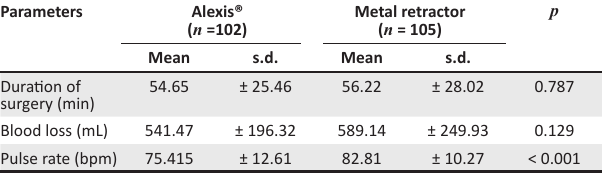
TABLE 2: Comparison of outcome parameters between the two groups ( n = 207).